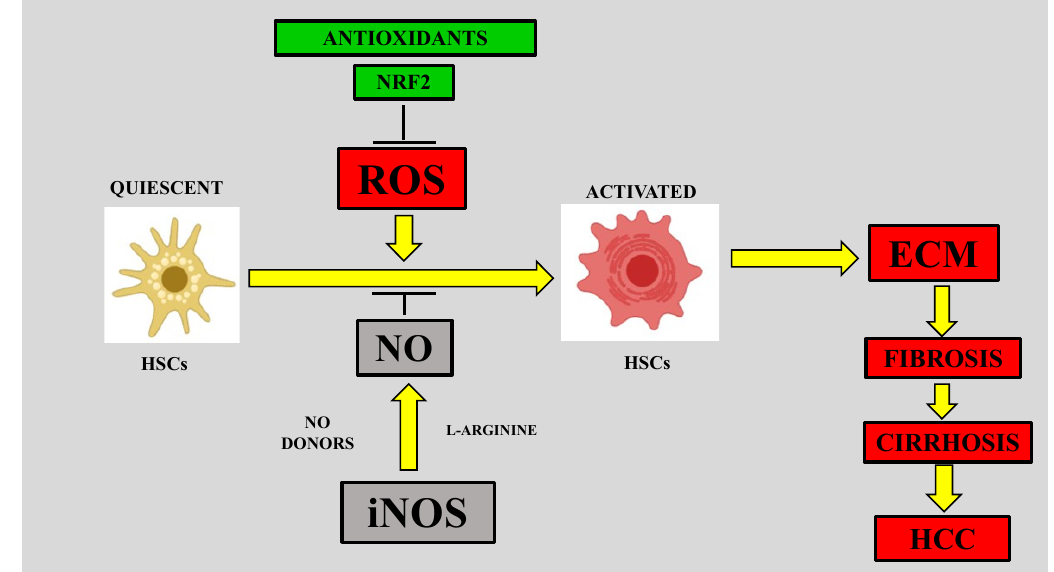
Figure 1. Reactive oxygen species (ROS) can induce the activation of hepatic stellate cells (HSCs), leading to the deposition of extracellular matrix (ECM) proteins, fibrosis, cirrhosis, and hepatocellular carcinoma (HCC). ROS promote the activation of HSCs from a quiescent state, which is the ECM-producing phenotype; in turn, ECM deposition leads to fibrosis, cirrhosis, and eventually HCC. Antioxidants, nuclear factor-E2-related factor-2 (NRF2) and nitric oxide (NO) seem to play antifibrotic roles by inhibiting ROS-induced HSC activation. Inducible nitric oxide synthase (iNOS) can synthesize large amounts of NO in the liver, utilizing L-arginine as a substrate.